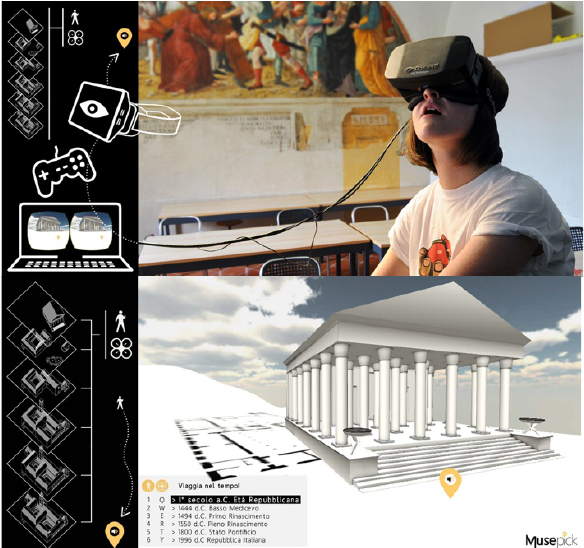
Figure 13. The head mounted display, Oculus Rift beta2, used for the experimentations (above) and the 3D model of the phase 1